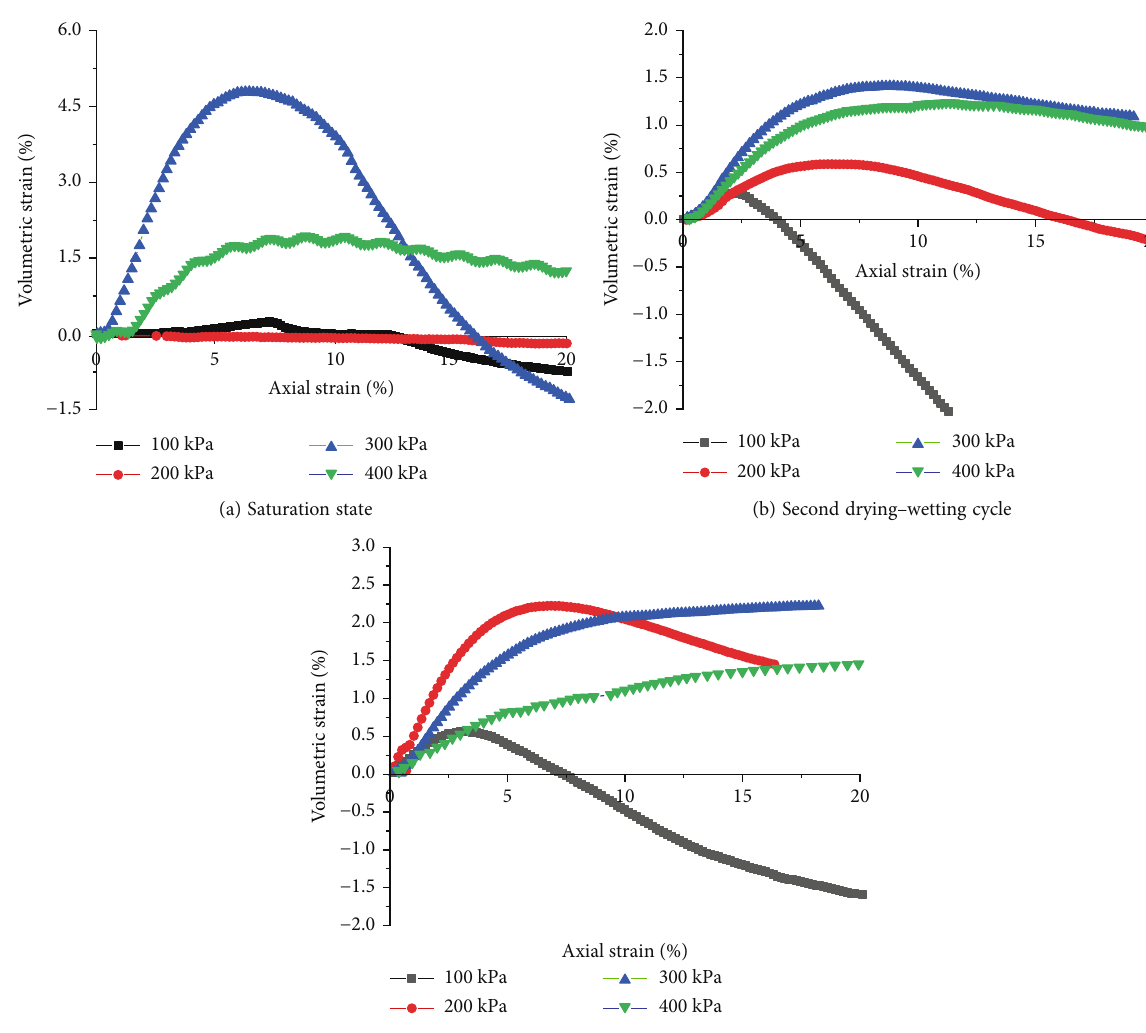
Figure 10: Volumetric strain – axial strain curves under di ff erent con fi ning pressures and the same number of drying – wetting cycles.